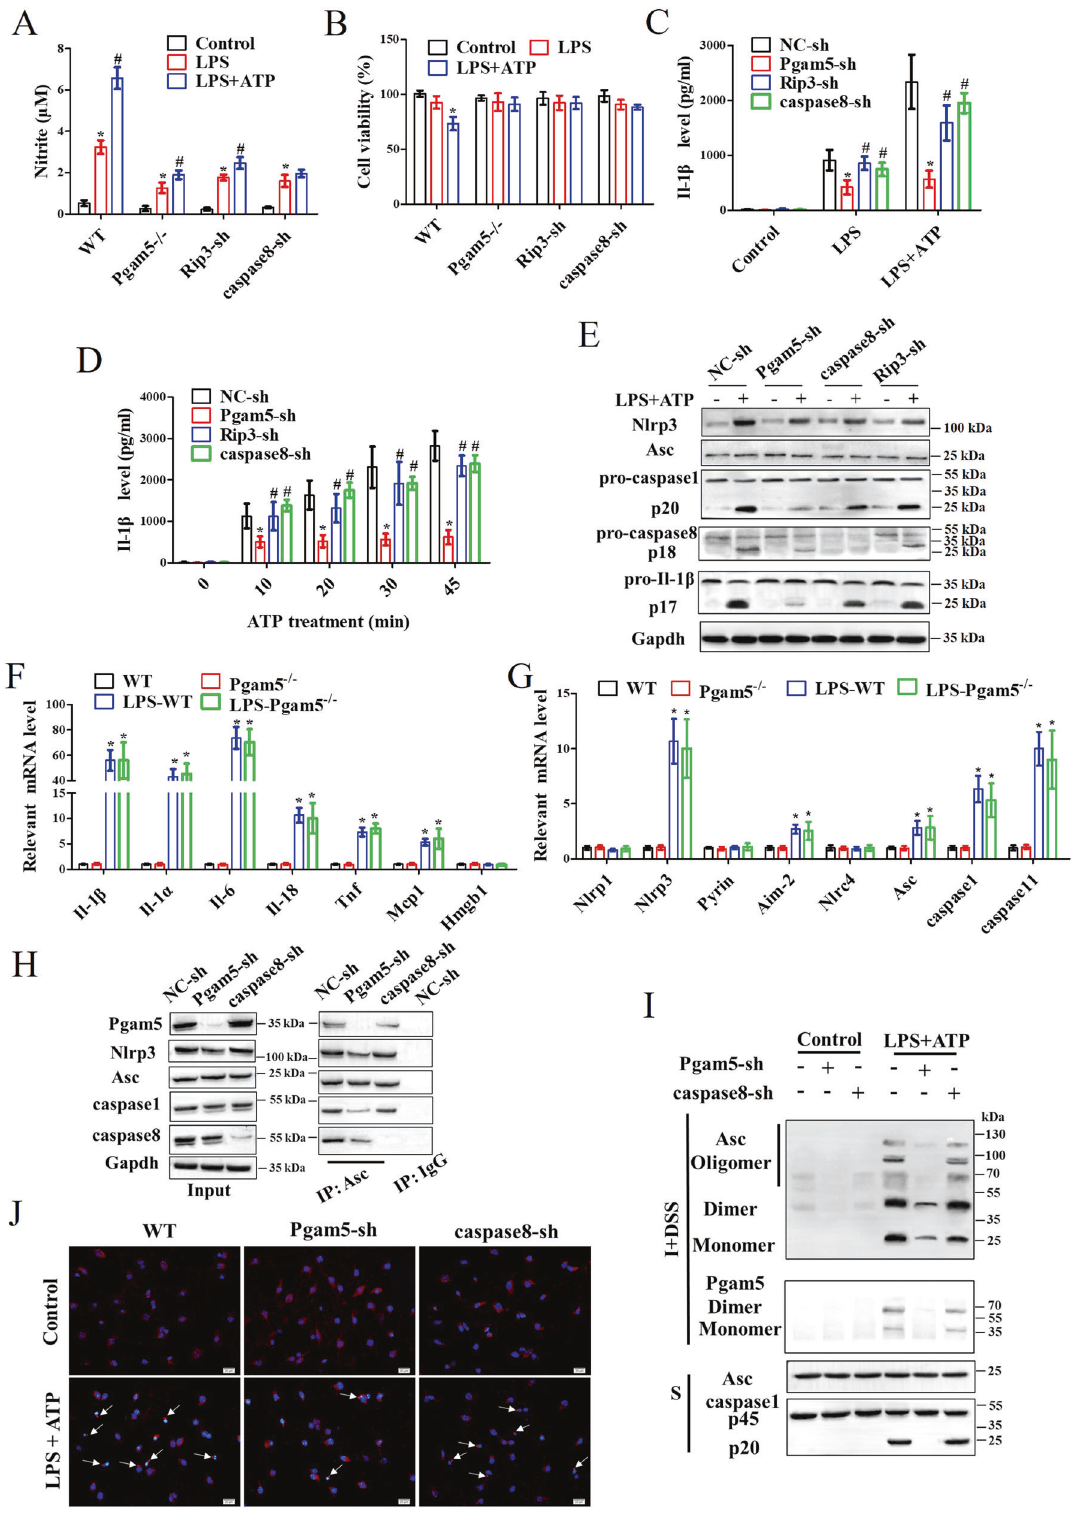
improve the prognosis of TBI [26, 27]. In clinical practice, Helmy et al. have demonstrated that the injection of recombinant IL-1R promotes in fl ammasome activation including Il-1 β secretion